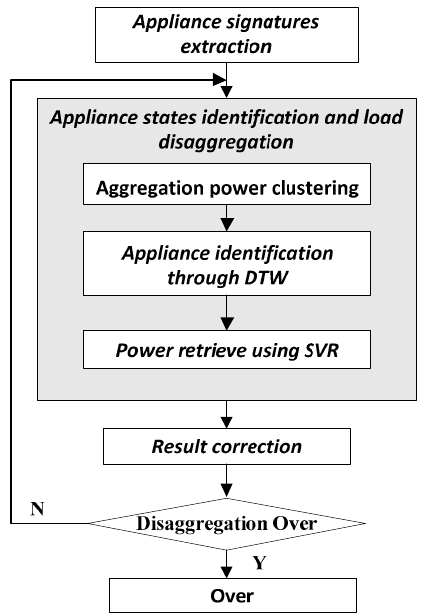
Figure 1. The flowchart of the proposed algorithm in this paper. 112